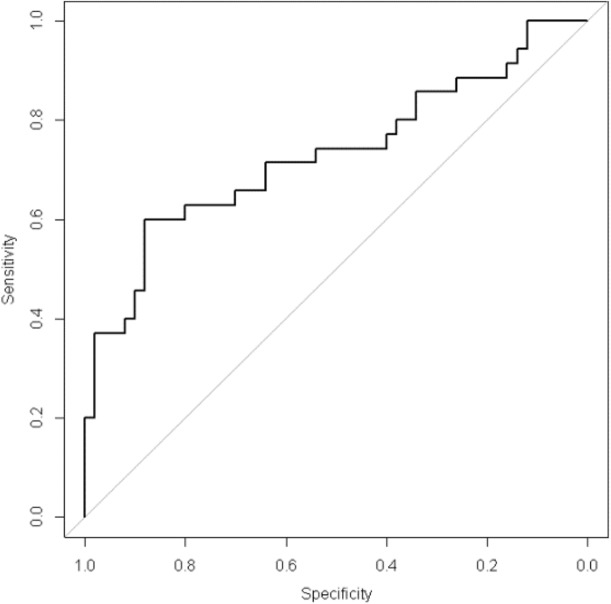
ROC curve to evaluate the predictive value of follicular fluid cfDNA level for clinical pregnancy outcome in a multivariate model (including the rank of IVF/ICSI attempts and the number of embryos): area under the curve = 0.73 [0.66–0.87], sensitivity = 60%, specificity = 88%.